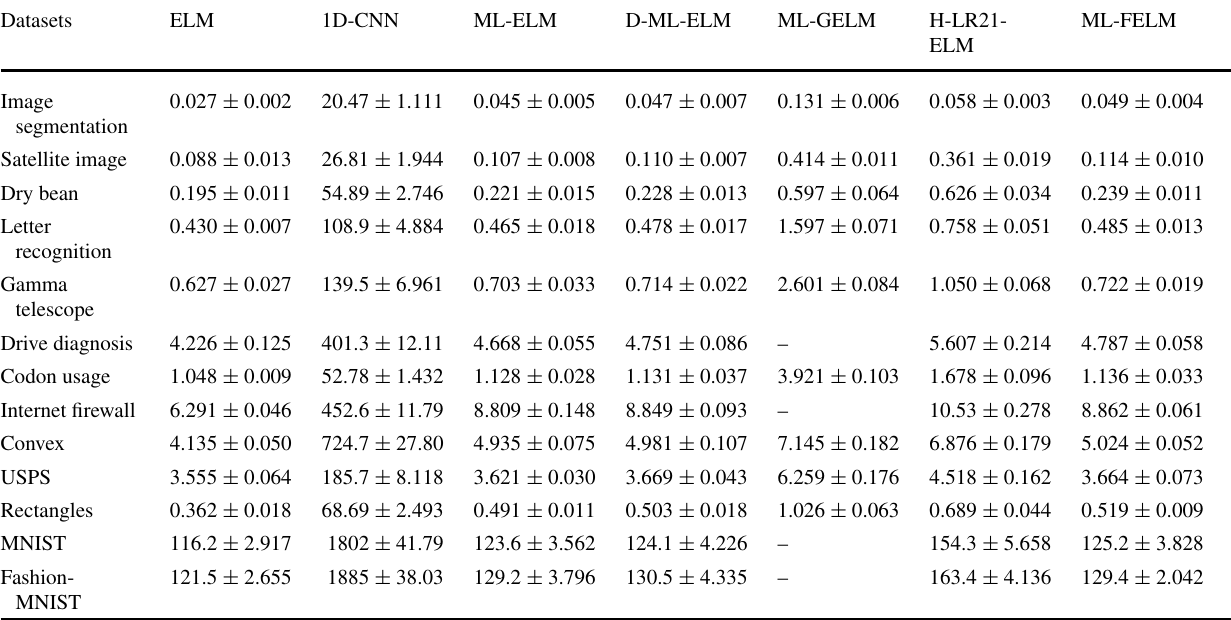
Table 5 The training time (s) of ELM, 1D-CNN, ML-ELM, D-ML-ELM, ML-GELM, H-LR21-ELM, and ML-FELM